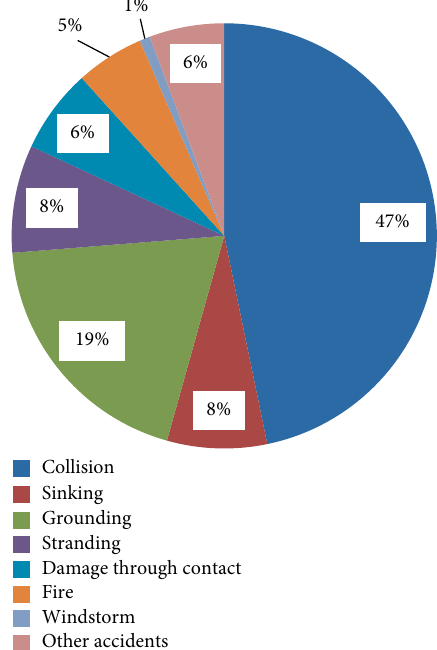
Figure 1: Yangtze River trunk line accident classification between 2010 and